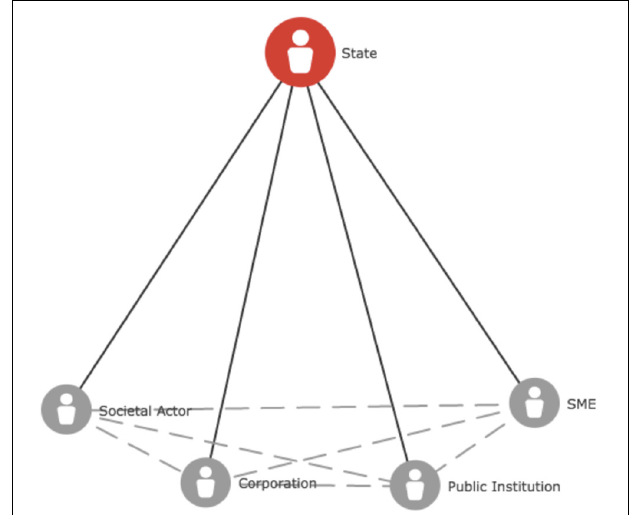
FIGURE 1 | Hierarchical command-and-control policy-making via the state. Within Mode 1, the state is sovereign and legitimate in commanding and controlling societal actors (both public and private; among private actors, for example, social groups and small and medium enterprises, SMEs). The identity of actors is perceived as the relevant aspect of power. Power relationships are vertical because they base themselves on the identity of the state as sovereign and